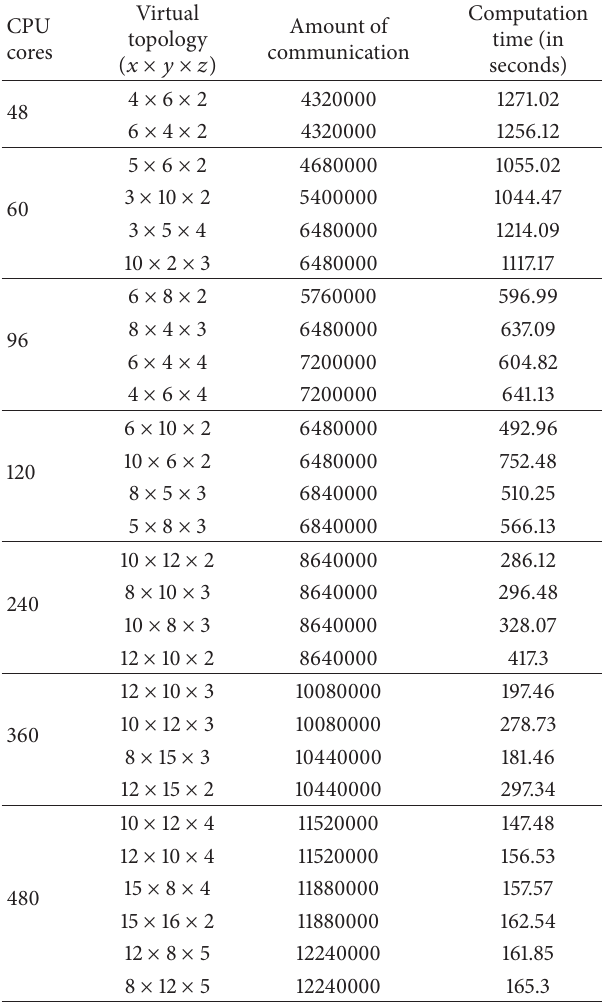
Table 3: Comparisons of virtual topology, amount of communica- tion, and computation time on